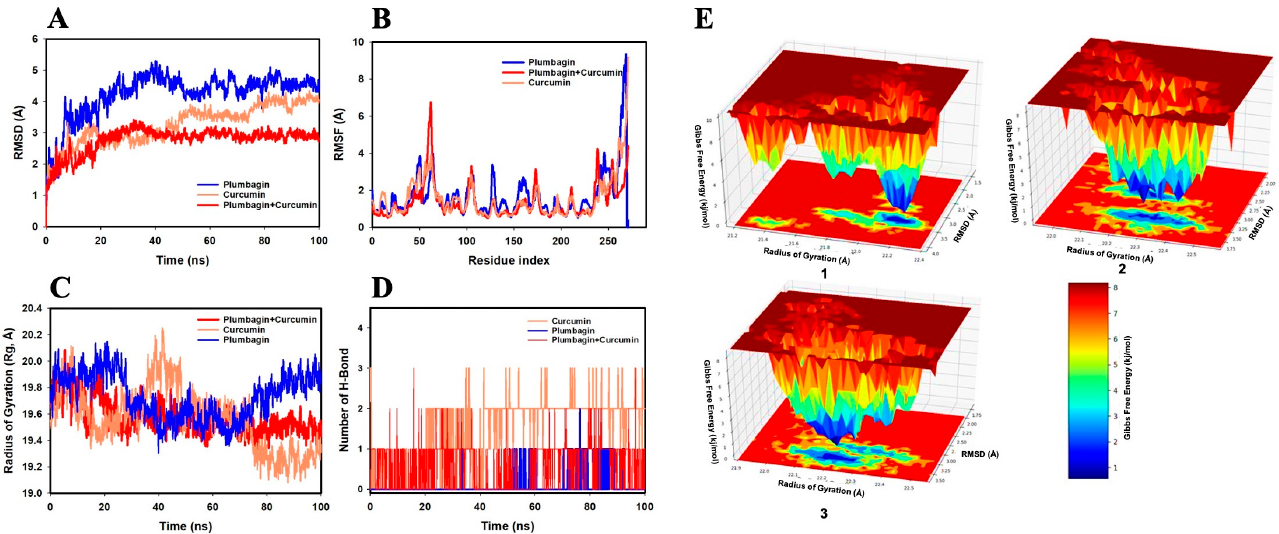
Figure 5. Analysis of MD simulation trajectories with a 100 ns time scale for the interaction of curcumin and plumbagin with PI3K. ( A ) Root means square deviation (RMSD) plot displaying the molecular vibration of C α backbone of PI3K-P (blue), PI3K-C (orange), and PI3K-C-P (red). ( B ) Root mean square fluctuation (RMSF) plot showing the fluctuations in respective amino acids throughout the simulation time of 100 ns for PI3K-P (blue), PI3K-C (orange), and PI3K-C-P (red). ( C ) Radius of gyration (Rg) plot for the deduction of compactness of PI3K-P (blue), PI3K-C (orange), and PI3K-C-P (red). ( D ) Number of H-bonds formed between PI3K and plumbagin (blue), PI3K and curcumin (orange), and PI3K and curcumin–plumbagin combination (red). ( E ) The free energy landscape (FEL) displaying the progression of global minima ( Δ G, kJ/mol) of PI3K in presence of ( 1 ) plumbagin, ( 2 ) curcumin, and ( 3 ) curcumin–plumbagin combination with respect to their RMSD (Å) and Rg (Å). The lower right panel displays the energy scale used in the measurement of FEL.